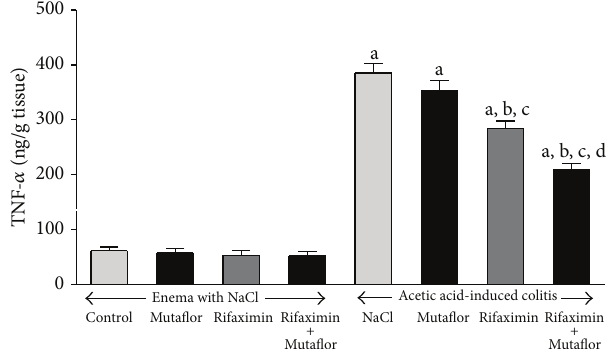
Figure 6: Influence of E. coli Nissle 1917 (Mutaflor) and rifaximin on of Tumor Necrosis Factor- 𝛼 concentration in colonic mucosa in rats without or with acetic acid-induced colitis. Mean value ± SEM. 𝑁 = 8 animals in each experimental group. a 𝑃 < 0.05 compared to control saline-treated rats without induction of colitis; b 𝑃 < 0.05 compared to colitis + NaCl; c 𝑃 < 0.05 compared to colitis + Mutaflor; and d 𝑃 < 0.05 compared to colitis + rifaximin.